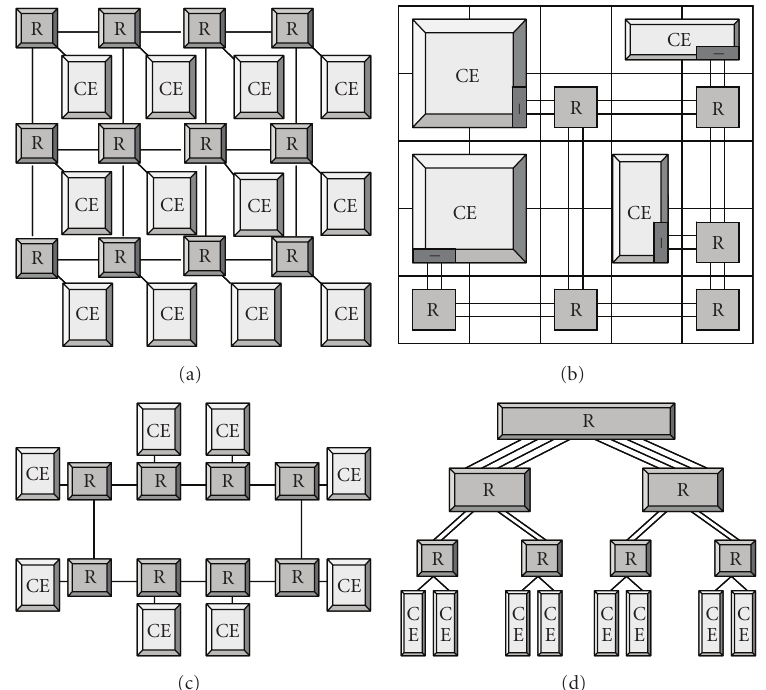
Figure 2: Network topologies: (a) mesh, (b) application-dependent topology, (c) ring, and (d) tree. Routers are denoted with “R” and communicating elements with “CE”.